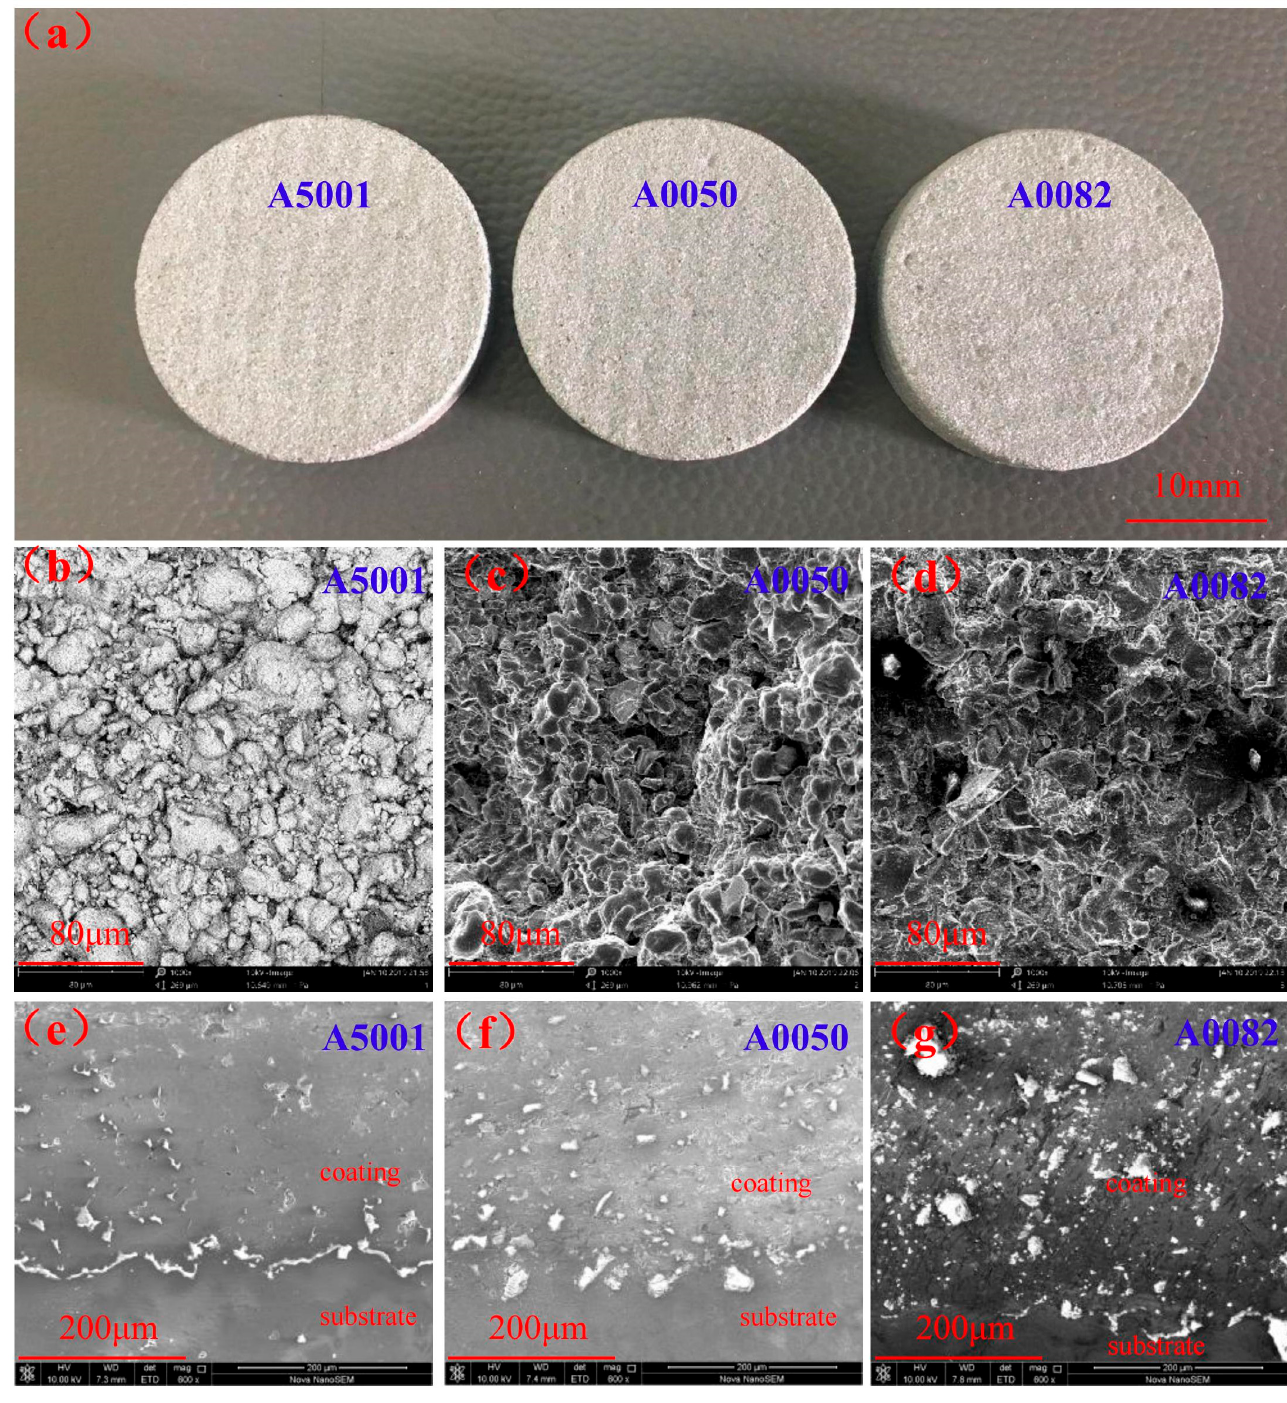
Figure 1. Surface morphology of different powder cold-sprayed coatings: ( a ) macroscopic morphol- ogy; ( b – d ) microscopic morphology; ( e – g ) cross-section morphology.